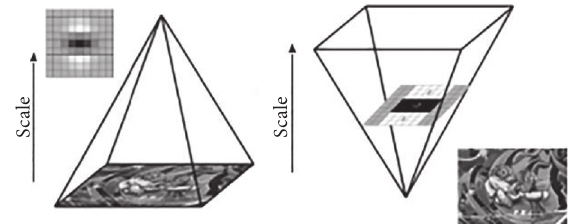
( X, σ ) and L ( X, σ ) by using box filters. yy xy